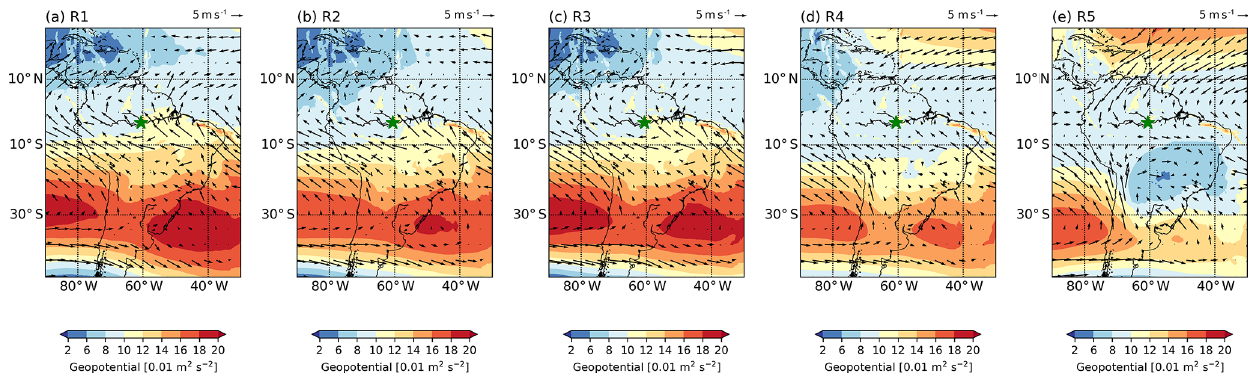
Figure 5. Composite large-scale synoptic patterns (geopotential heights in color – 0.01m 2 s − 2 – and horizontal winds) projected onto each regime from ERA5 for the 1000hPa level. The green star indicates the ARM MAO